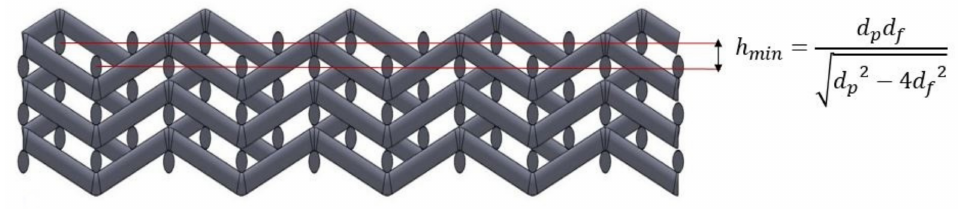
Figure 2. Corresponding to woven wire-mesh geometry with spacing between screens: ( a ) Isometric view. ( b ) top view. ( c ) front view and ( d ) side view.